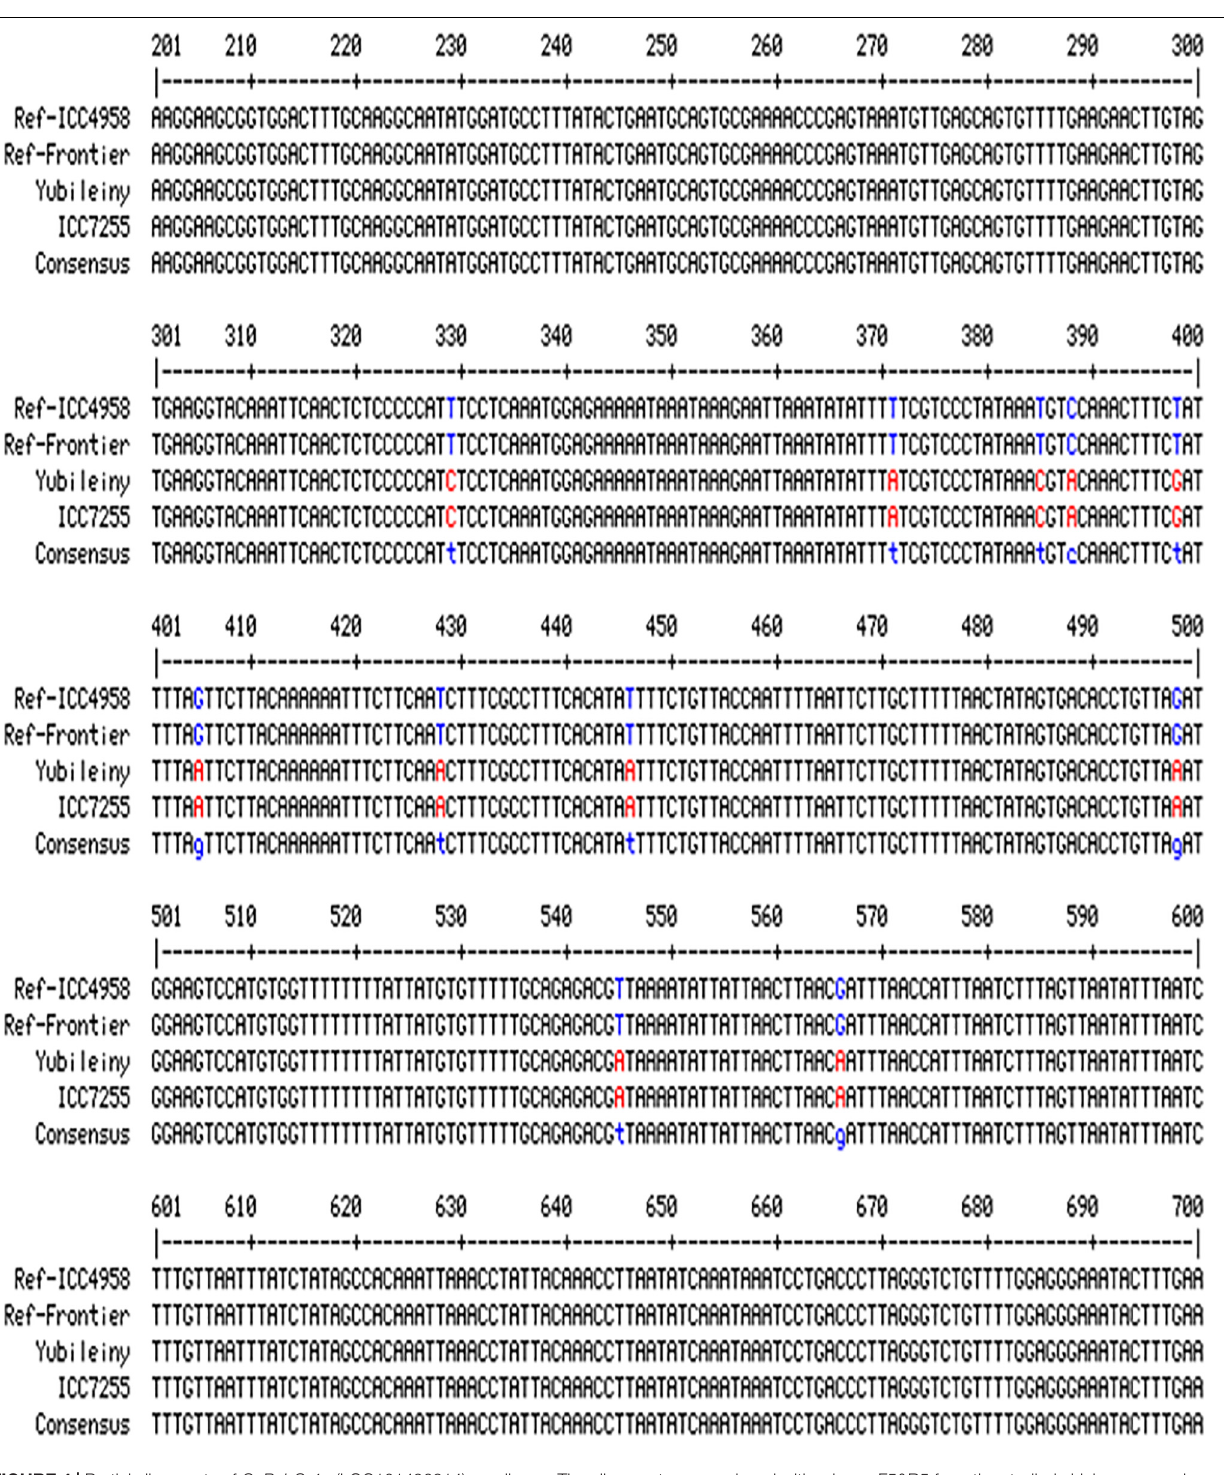
FIGURE 4 | Partial alignments of CaRabC-1a (LOC101496214) amplicons. The alignment was produced with primers F5&R5 from the studied chickpea germplasm, Yubileiny and ICC7255, compared to two fully sequenced reference accessions, ICC4958 and Frontier. The studied amplicons were located on Chromosome 4, position 27,819,854–27,818,706 (Reverse order), in the reference accession ICC4958 (Desi ecotype), while the amplicon position in the second reference accession Frontier (Kabuli ecotype), was at 38,617,439–38,616,292 (Reverse order), also on Chromosome 4. Eleven identified SNPs are shown in red for the two studied accessions against those indicated in blue for the two reference